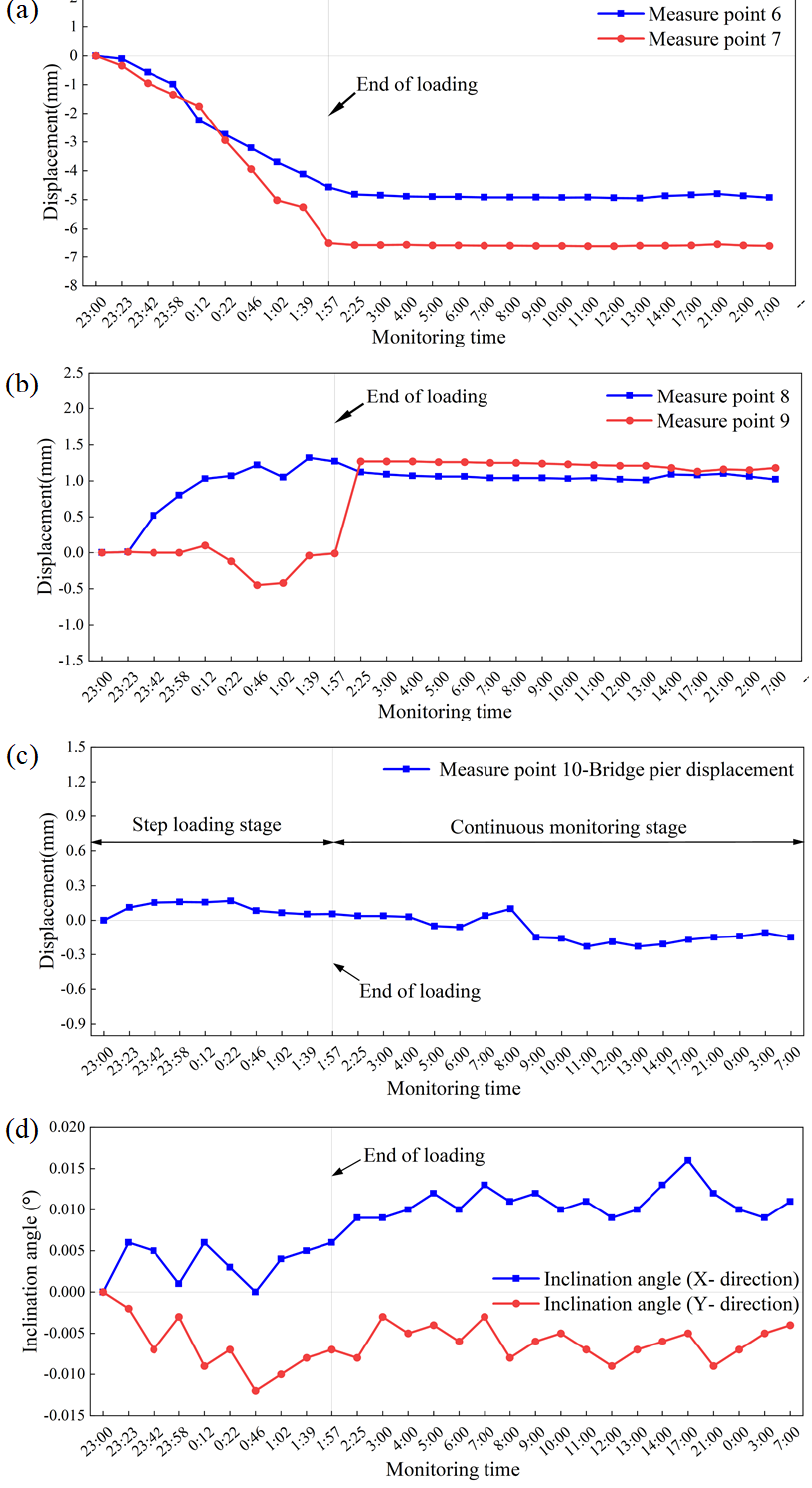
Figure 11. Displacement monitored during jacking-up stage: ( a ) displacement of new pile; ( b ) dis- placement of underpinning beam; ( c ) displacement of bridge pier; and ( d ) pier inclination.